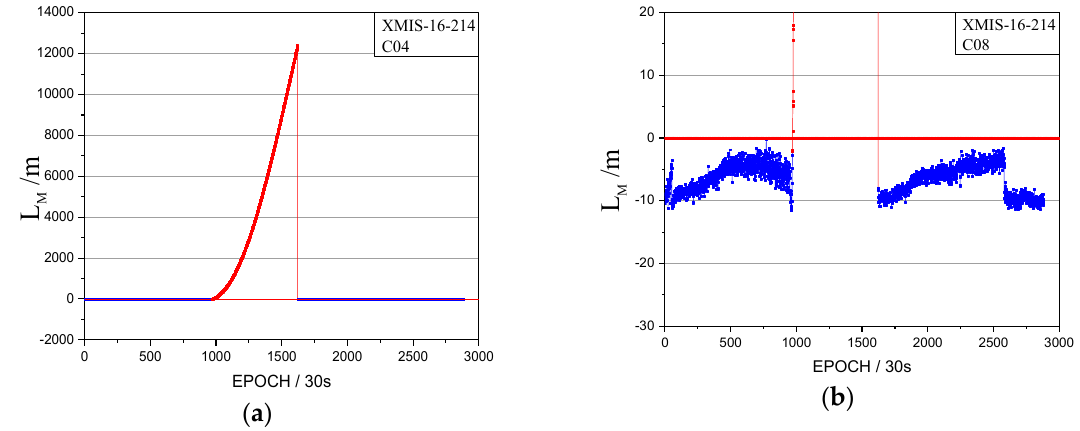
Figure 9. The satellite factors of the orbital maneuver for C08 on 1 August 2016. ( a ): The normal vertical axis scale shows overall information; ( b ): The amplified vertical axis scale shows more detailed information.